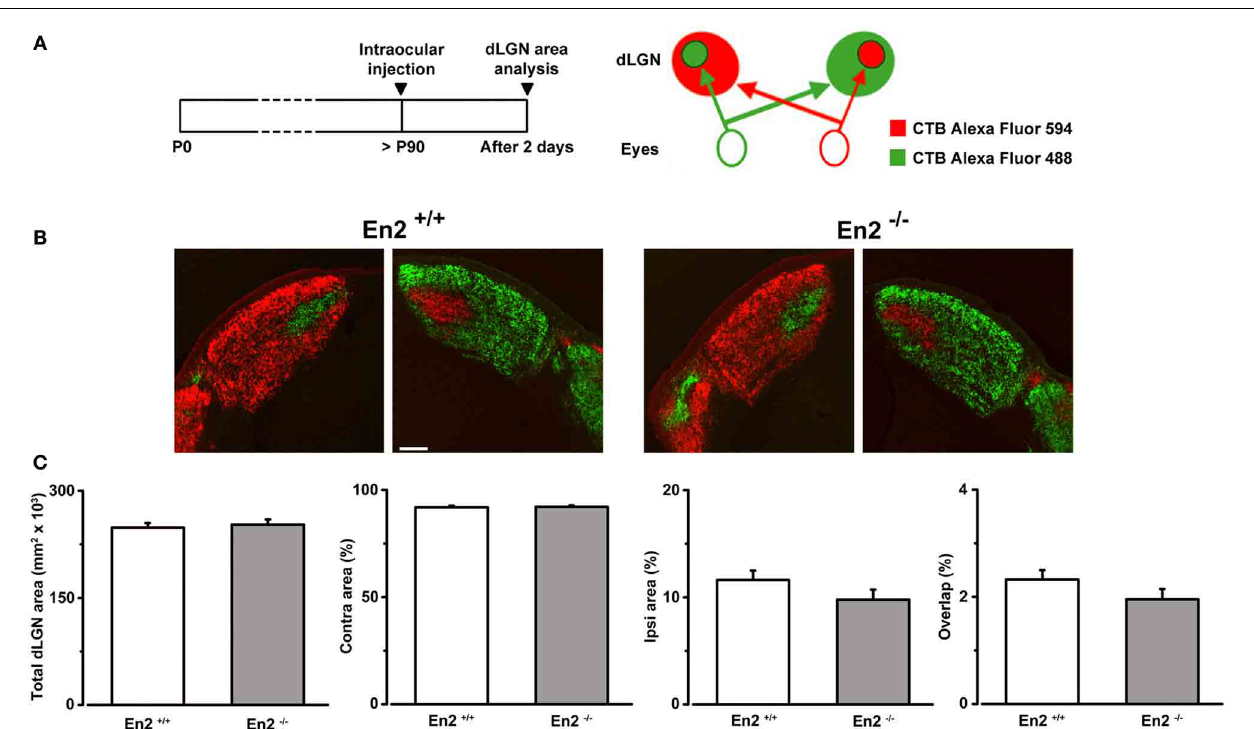
FIGURE 6 | Normal segregation of eye specific inputs in the dLGN of En2 − / − adult mice. (A) Schematics of the experimental protocol for anterograde labeling of retino-geniculate afferents. (B) Representative coronal sections of both right and left dLGN in En2 + / + and En2 − / − mice. Scale bar: 200 μ m. (C) Quantification of